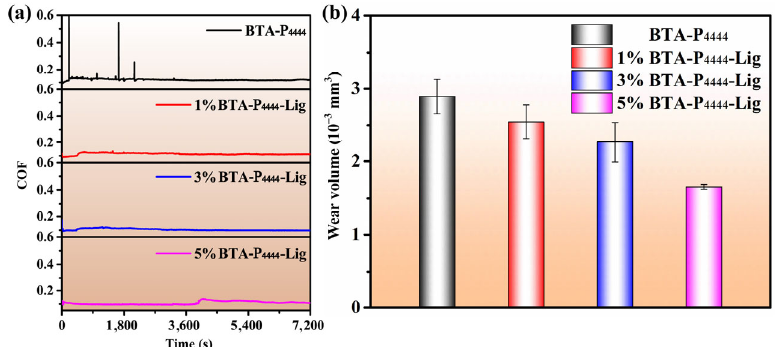
Fig. 4 COF evolution and WVs of BTA-P 4444 -Lig as a lubricant for steel/steel friction pairs (test conditions: 300 N, 50 Hz, 1 mm, 50 °C, and 120